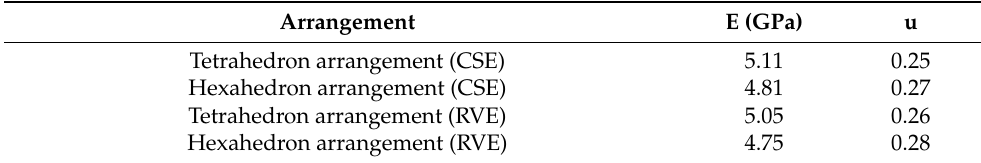
Table 1. Elastic properties of materials calculated.